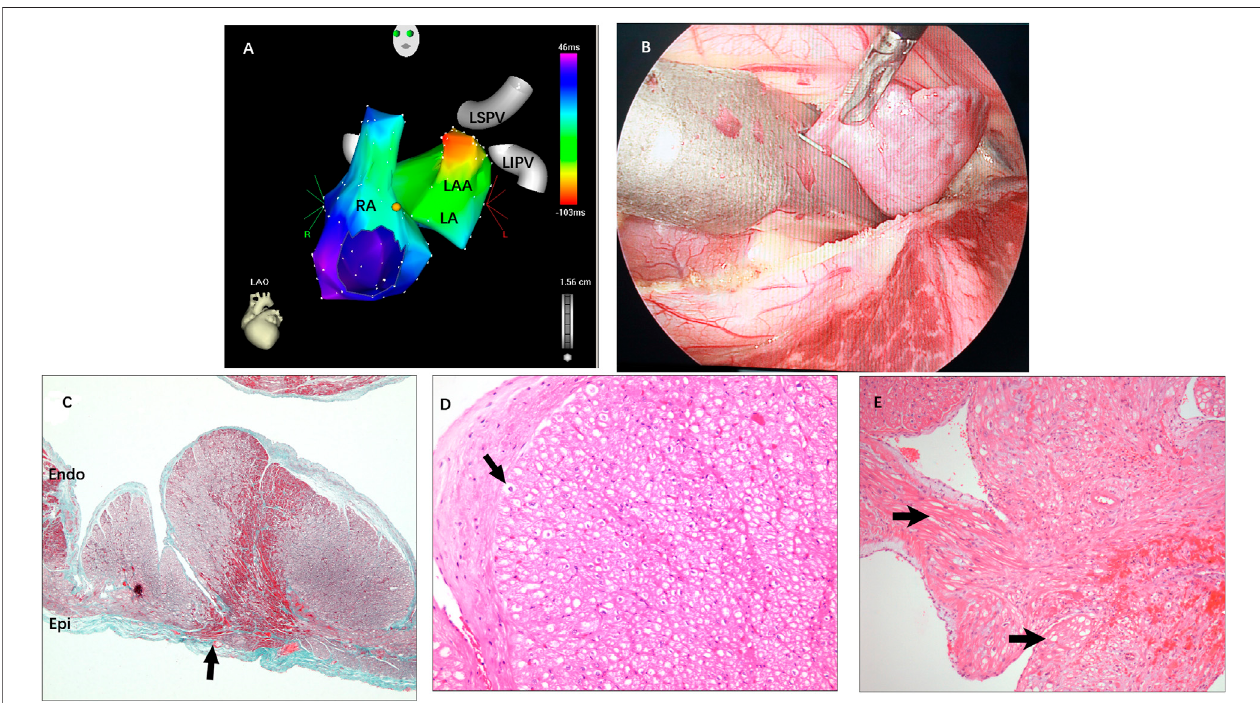
FIGURE3|(A) Activation mappingofAAToriginatingfrom thedistalLAA. (B) TheLAA wasclamped and excised fromthe baseusing anendoscopic linearstaple. (C) Pathohistology of excised LAA: A transmural lesion was noted with granulation and fi brosis next to hemorrhage (arrow). (D) Mild vacuolar degeneration of cardiomyocytes in the apex of the LAA (arrow) and absence of sinoatrial node-like tissue. (E) The area in the vicinity of the lesion was interspersed with abundant nuclei- absent cells that clustered to form a kidney-shaped fi guration (arrow). RA = right atrium; LA = left atrium; LSPV and LIPV = left superior/inferior pulmonary vein; Other abbreviations as previously.